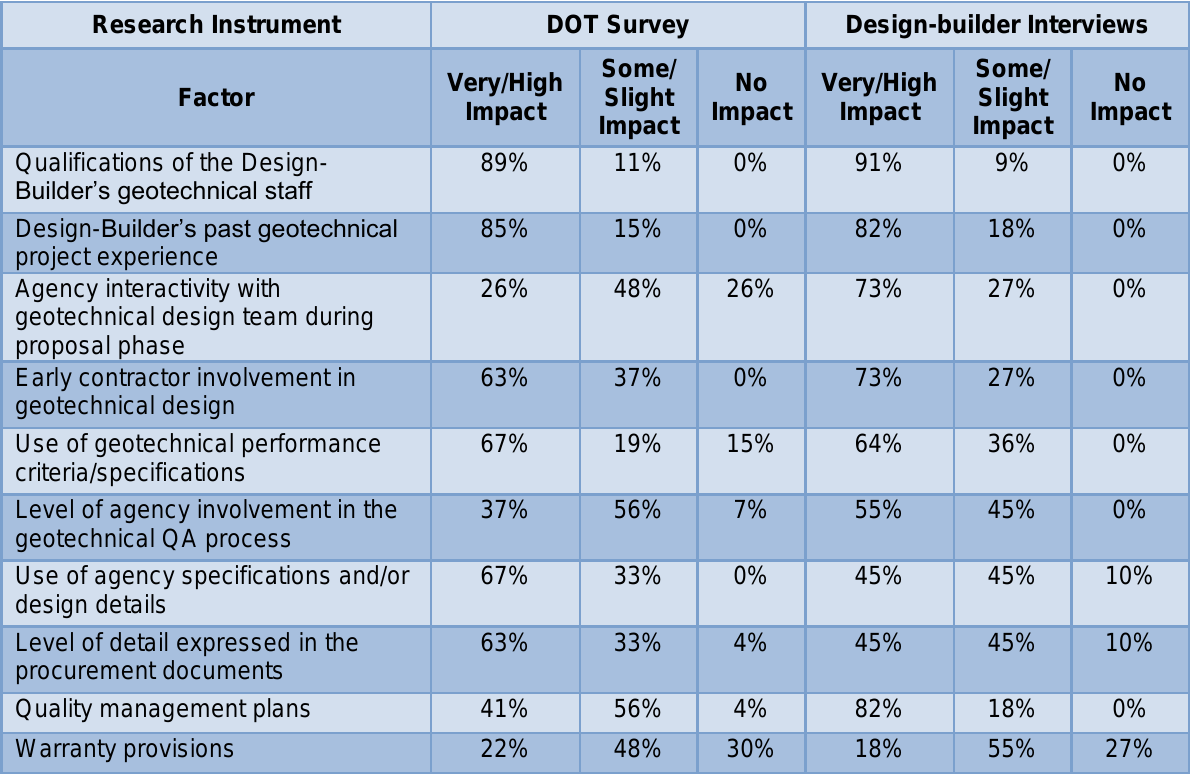
Table 5 Impact on final project